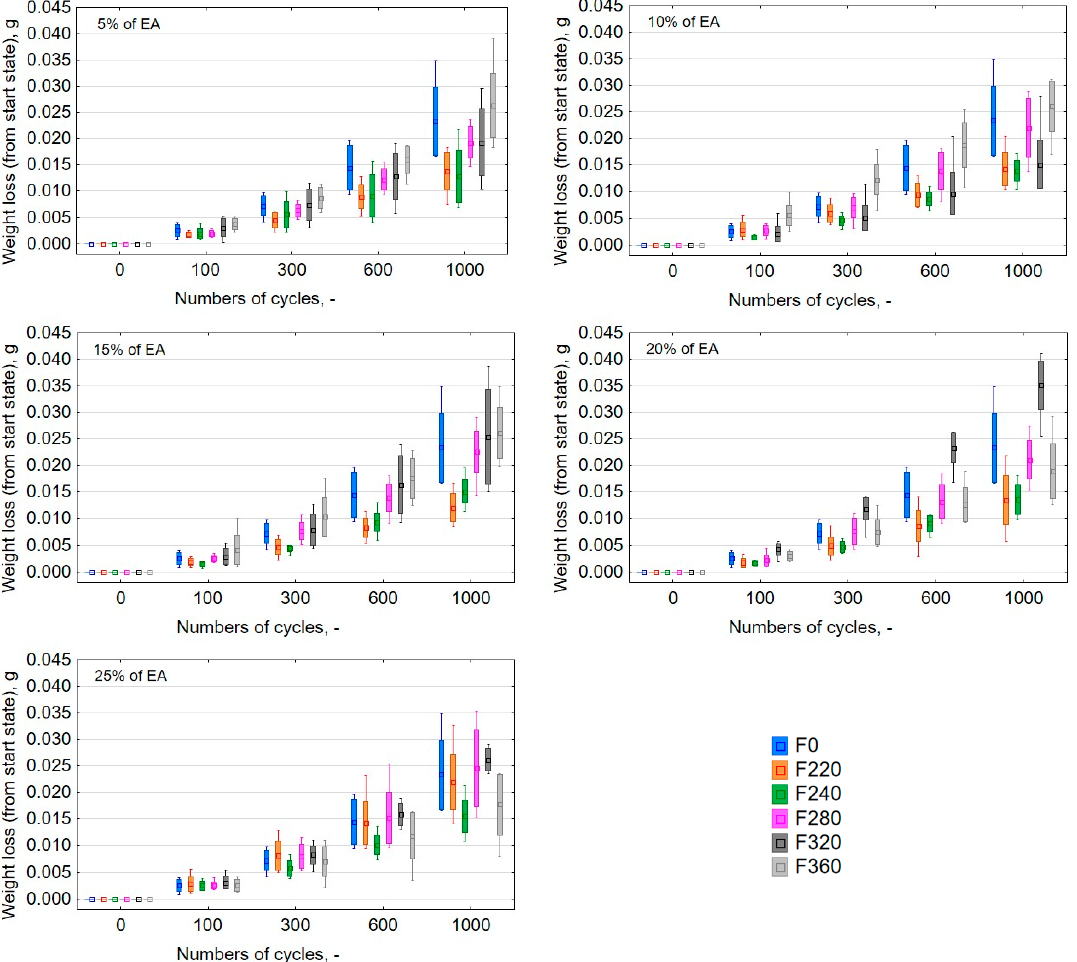
Figure 3. Weight loss graphs against the number of cycles for samples made with L285 resin and H285 hardener with an addition of alundum with the following grains: F220, F240, F280, F320, and F360 for percentage mass share of the physical friction modifier equal to 5%, 10%, 15%, 20%, and 25%, respectively.